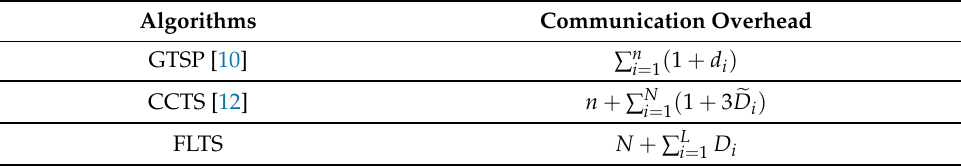
Table 1. Communication Overhead Comparison.